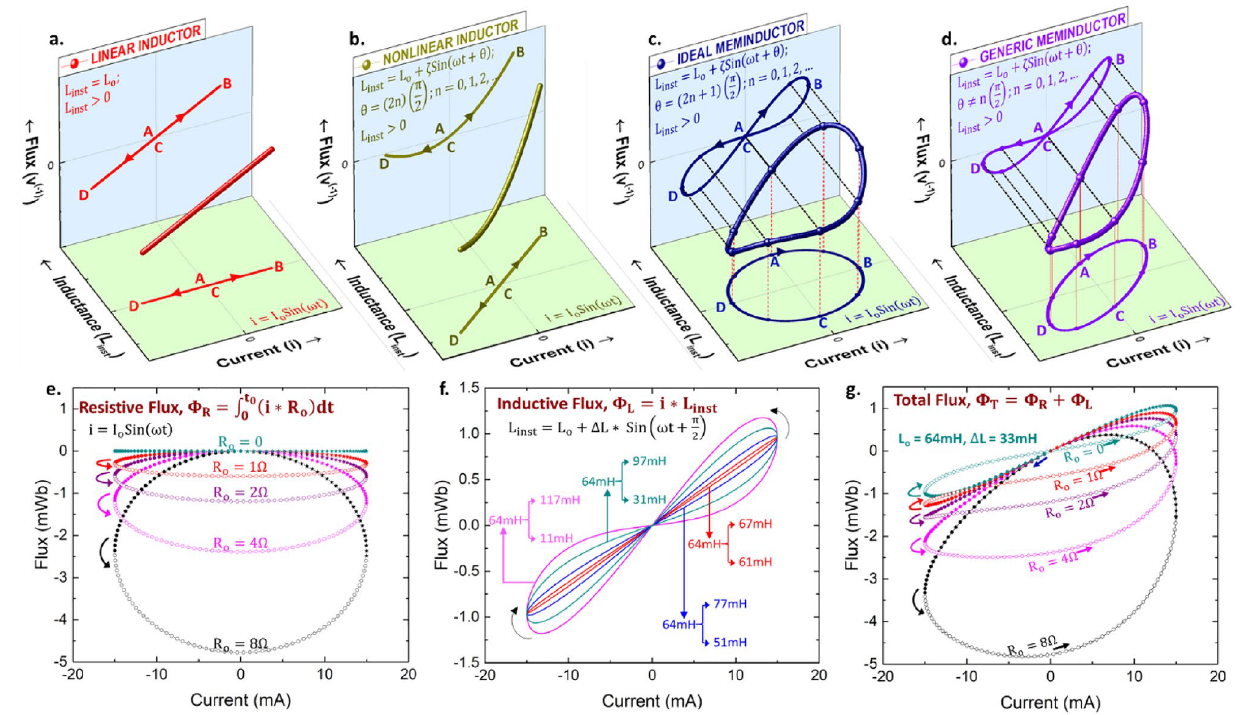
Figure 1. Physical realization of a meminductor: approach and challenges. ( a – d ) Choice of the ordered triple as (i, v (−1) , L inst ) identifies the two-terminal circuit element as a current sourced inductor. For a sinusoidally varying i(t), a constant L inst yields a linear inductor ( a ), whereas a time variation induced in L inst due to its state-dependence introduces nonlinearity. A sinusoidal fit for L inst is chosen here for clear illustration. The phase difference between i(t) and L inst being even multiples of π 2 results in an ideal non-linear inductor ( b ), a phase difference of odd multiples of π 2 results in an ideal meminductor ( c ), and any other phase difference results in a generic meminductor ( d ). ( e–g ) Impact of series resistance on pinched hysteresis behavior of a meminductor: illustrated for a winding driven by a sinusoidal current signal, i(t) with I o = − 15 mA and f = 8 Hz. Resistive flux, Φ R : series resistance, R o results in a right-handed ellipse in the (i, Φ R ) plane ( e ), Inductive flux, Φ L : winding inductance, L inst results in a pinched hysteresis curve in the (i, Φ L ) plane, illustrated for L o = 64 mH with ΔL = 53 mH (magenta), 33 mH (cyan), 13 mH (blue), and 3 mH (red) ( f ), Total flux, Φ T , calculated as the sum of resistive and inductive flux components illustrates the pinch point of the meminductive response of a winding with (L o , ΔL) = (64 mH, 33 mH) made to disappear by series resistances 2 Ω and greater at 8 Hz ( g